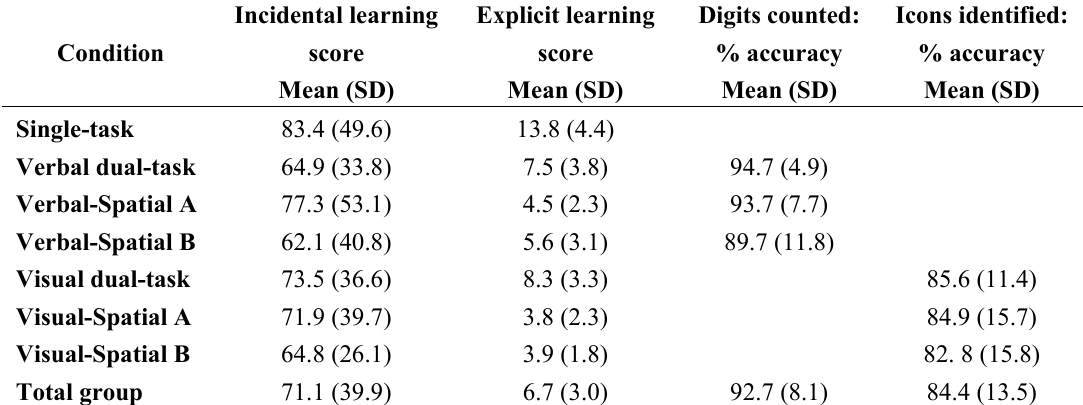
Table 2. Descriptive data for incidental learning, explicit learning and percentage accuracy scores ×